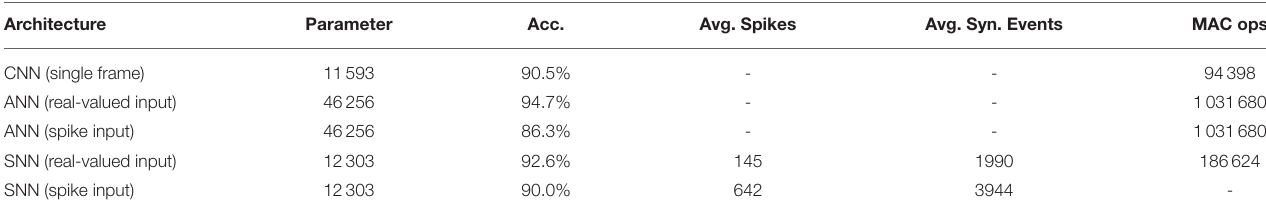
TABLE 2 | Radar object classification